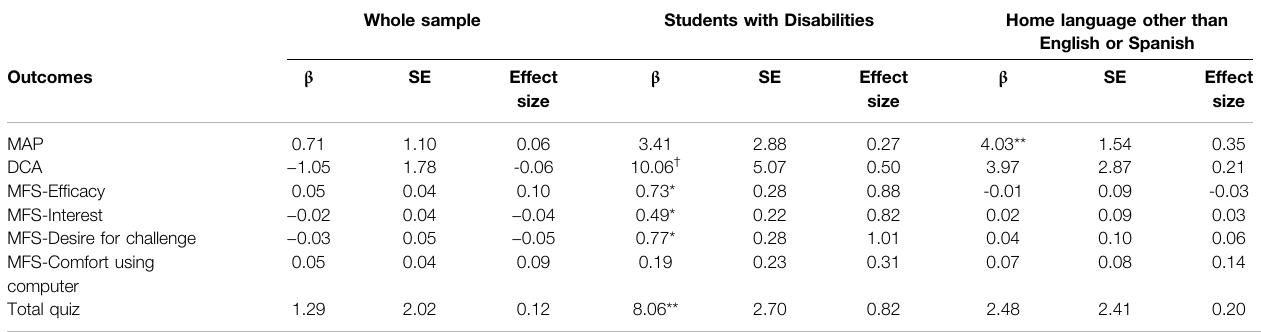
TABLE 3 | Estimated treatment impact among the whole sample and among students with disabilities. Whole sample Students with Disabilities